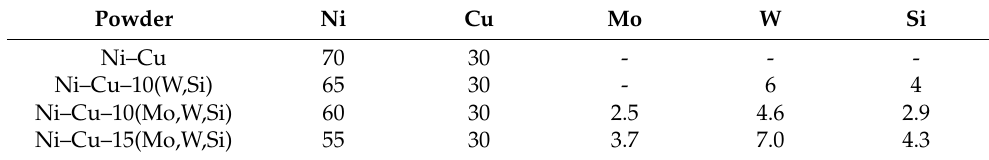
Table 1. Coating powder mass components